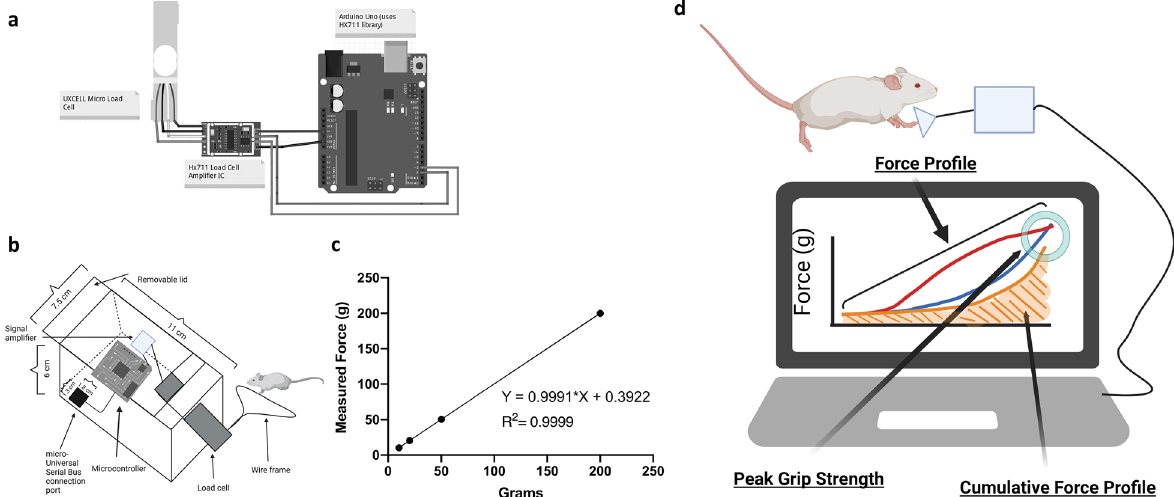
Figure 1. Microcontroller enables simultaneous measure of three distinct grip parameters. ( a ) Schematic representing the configuration of a force-sensitive resistor cell (UXCELL Micro Load Cell) to an amplifier (Hx711 Load Cell) that uses a microcontroller (Arduino) to interface with any OSX/Windows operating system. ( b ) View of the external apparatus housing containing the circuit. Power is connected with micro-universal serial bus port. Removable allows access to adjust circuit as needed. ( c ) Linear regression of the detected force in response to check weights. Applied force is highly linear within the typical dynamic range of grip strength measurements (****p < 0.0001, Pearson’s Correlation, R 2 = 0.9999). ( d ) Illustration displaying the detection of peak grip strength (highest point for force), force profile (the shape of the line), and cumulative force profile (the area under the force profile curve). The three lines represent hypothetical curves obtained for three distinct mouse subjects. The blue line illustrates the force profile of a control or wild-type mouse without physiological perturbation, and the highest point shows the maximum grip strength. The yellow line represents the force profile of a mouse with reductions in both force profile and peak grip strength. The red line illustrates the force profile of a mouse with a similar peak grip strength as the control animal, but with a distinct force profile that suggests abnormal compensation to achieve the same peak grip